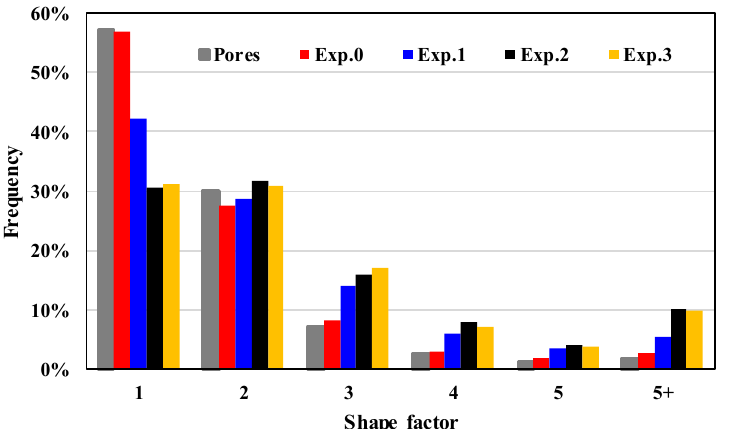
Figure 13. The distribution frequency of shape factor of pores and oil clusters in different stages.